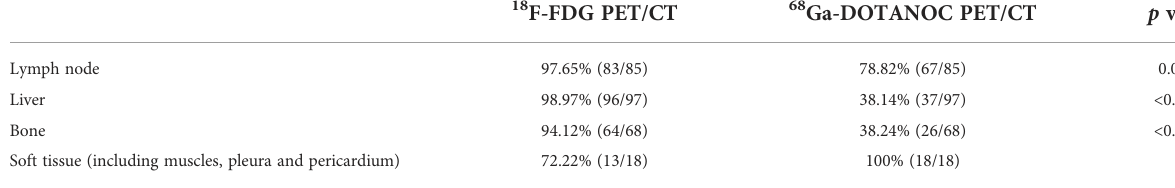
Soft tissue (including muscles, pleura and